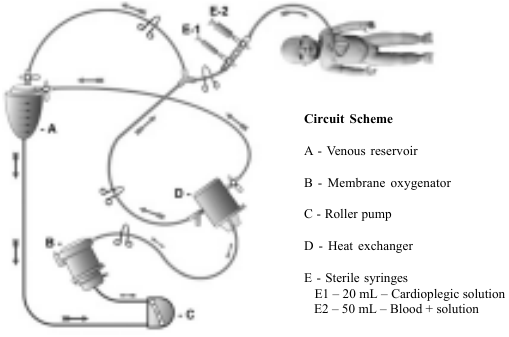
Fig. 1 – Scheme of the cardioplegic system